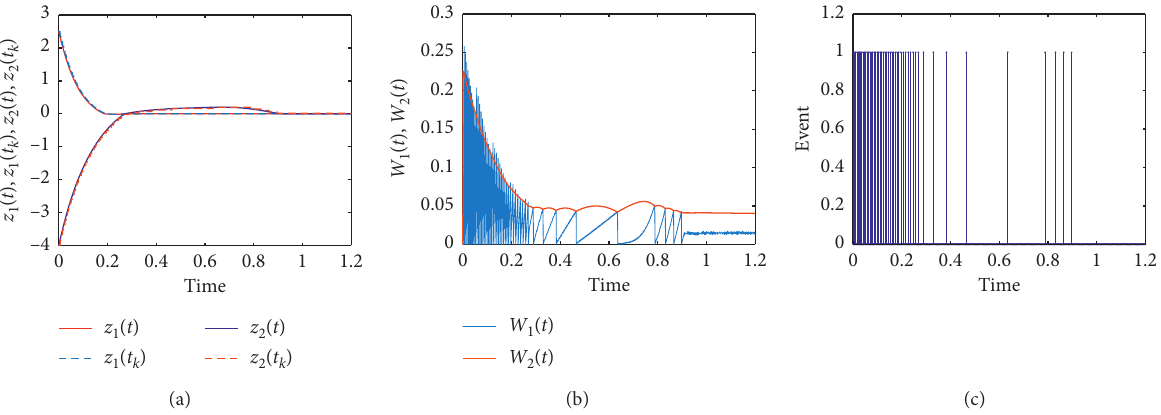
Figure 5: The dynamic event-triggering function (54) with ω � 0 . 25. (a) State trajectories of synchronization error system. (b) Trigger ( t ) � ‖ Δ z ‖ ( t ) � ζ ( t ) + ω ( η − H parameters W and W 1 1 2